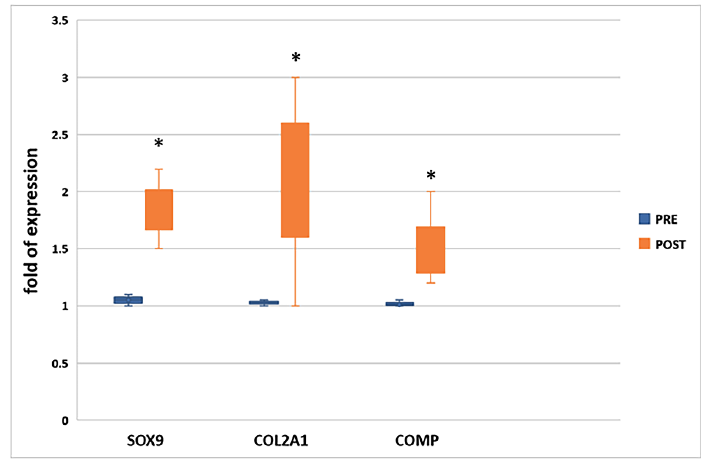
Figure 1. Chondrogenic transcription factor SOX9, as well as COL2A1 and COMP, were upregulated (fold of gene expression > 1) in CPCs collected after the run (POST) * p ≤ 0.05 vs. PRE.